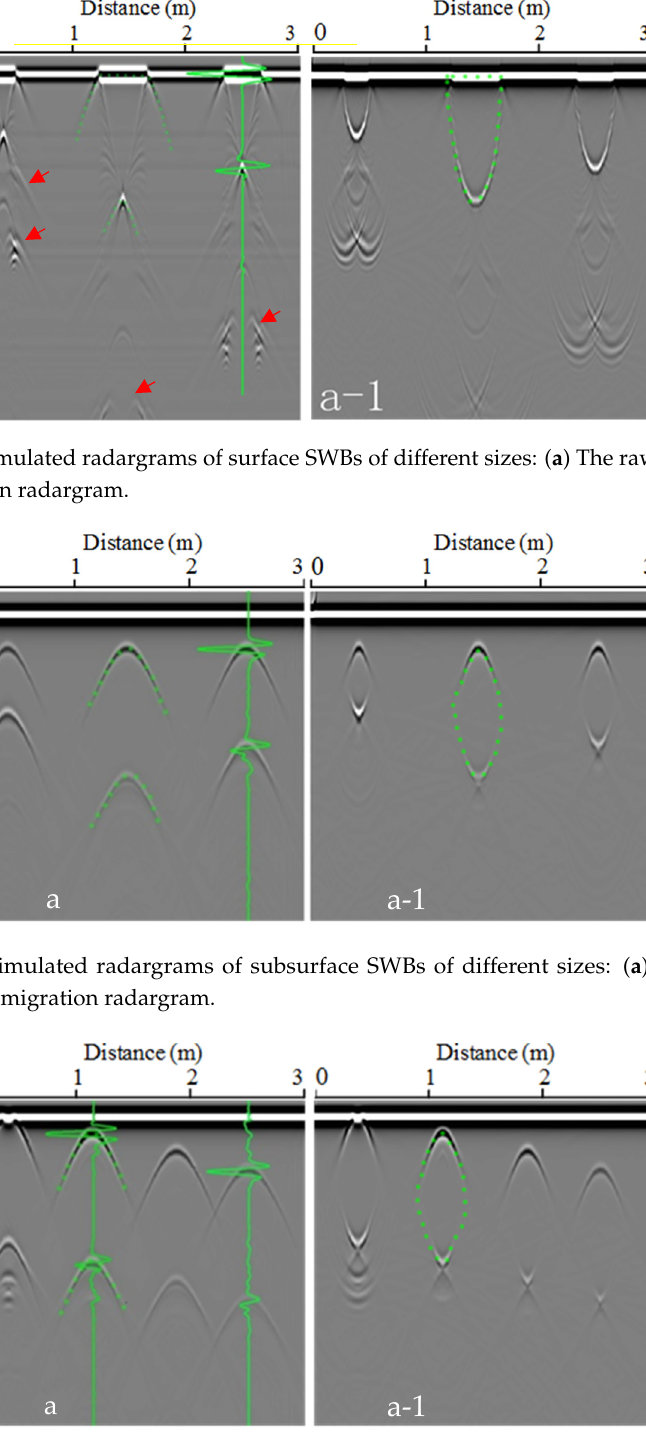
Figure 8. Simulated radargrams of subsurface SWBs of different depths: ( a ) The raw radargram; ( a-1 ) the FK migration radargram.